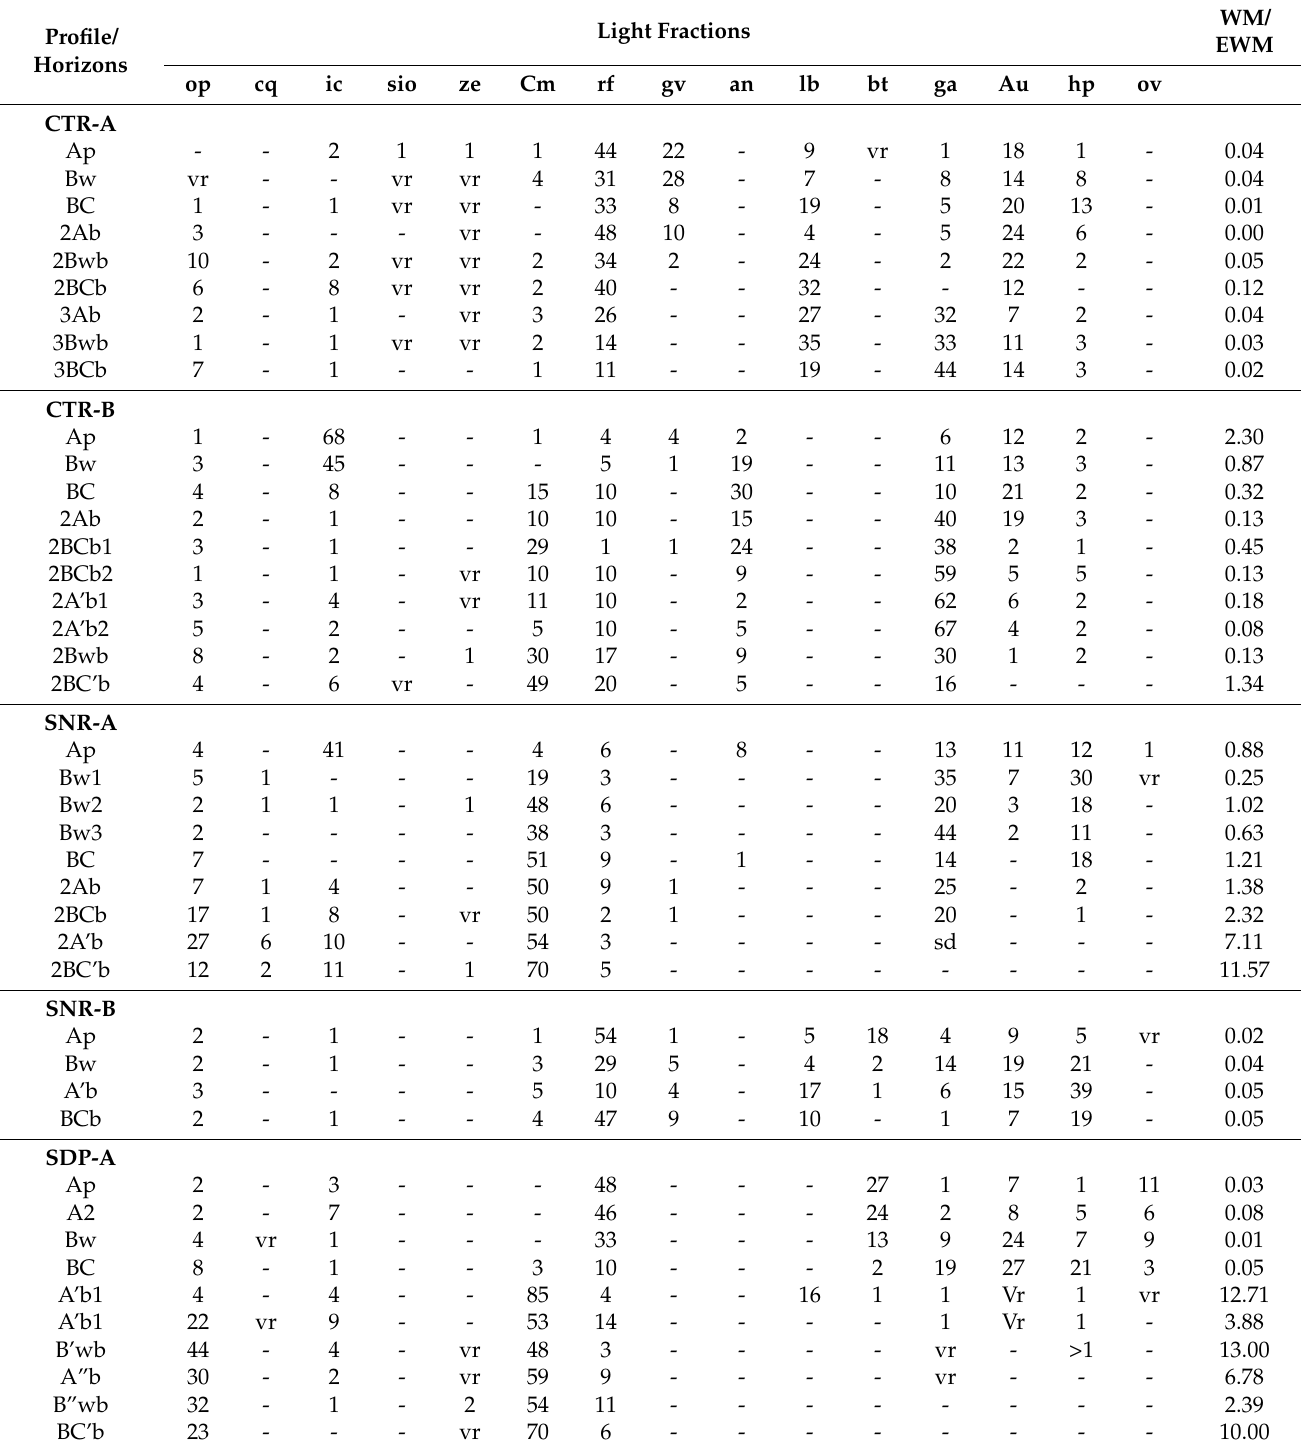
Table 3. Mineralogical compositions of the sand fractions of soils from different agro-climatic zones, of different types, and with different ages of parent